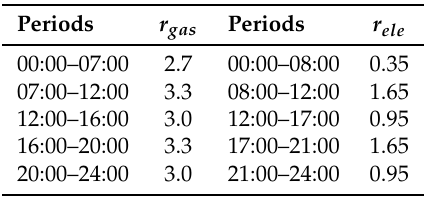
Table 2. Time-of-Use price of gas and electricity in a